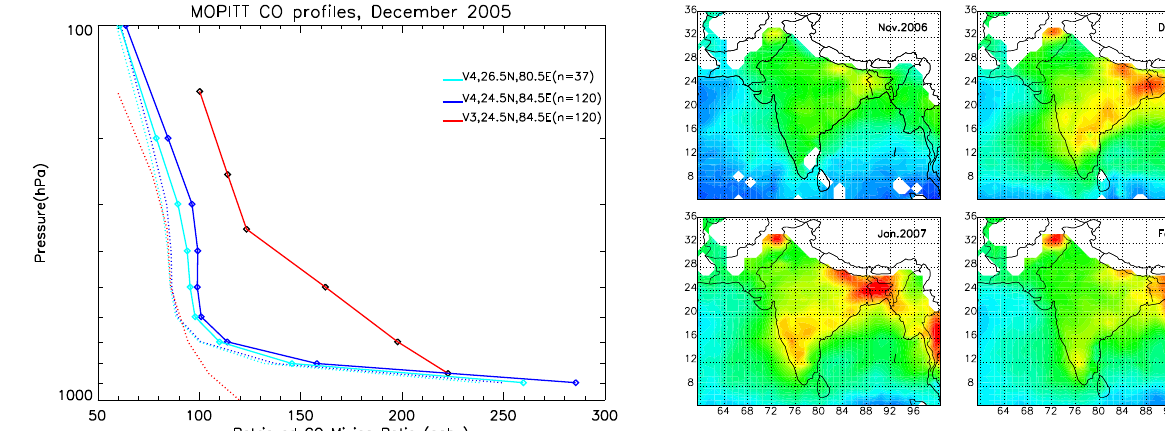
Fig. 1. MOPITT CO profiles at two locations over the Indo- Gangetic Plains (level 3 monthly mean gridded data). Note that there were no corresponding profiles within the grid cell centered at 26.5 ◦ N, 80.5 ◦ E in version 3 of MOPITT data. The dashed curves are the corresponding a priori profiles used in the CO retrievals. The number of profiles for each grid cell is shown in brackets.